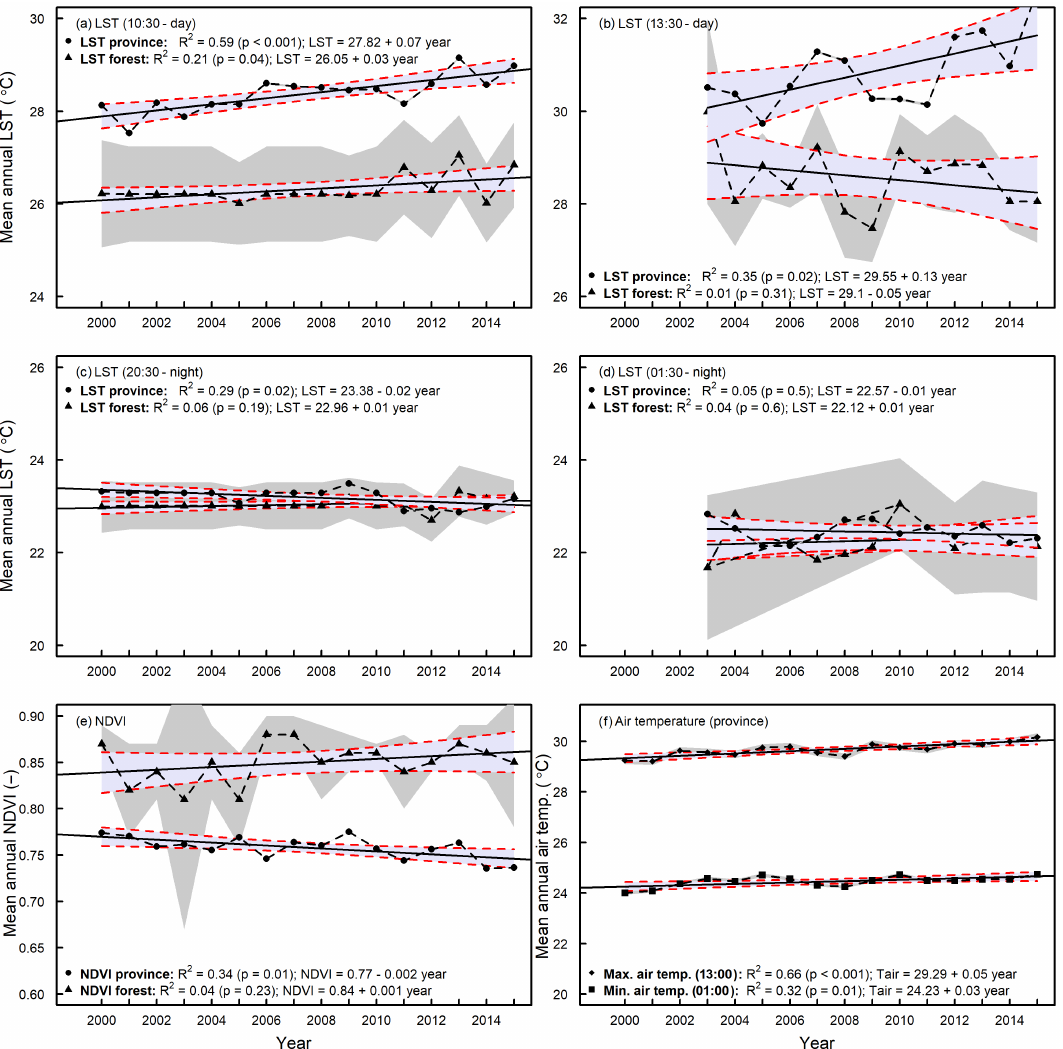
Figure 5. Mean annual LST (a–d) , mean annual NDVI (e) and mean annual air temperature trends (f) in the Jambi province between 2000 and 2015 derived from MODIS LST ( a 10:30, b 13:30, c 22:30 and d 01:30, local time), MODIS NDVI and ERA-Interim daily air temperature (01:00 and 13:00, local time) data sets, respectively. Grey-shaded areas are the confidence intervals of the means; blue-shaded areas are the confidence intervals of the regression lines. MODIS LST time series for 13:30 and 01:30 were available from the middle of 2002; for this reason we used the complete years from 2003 to